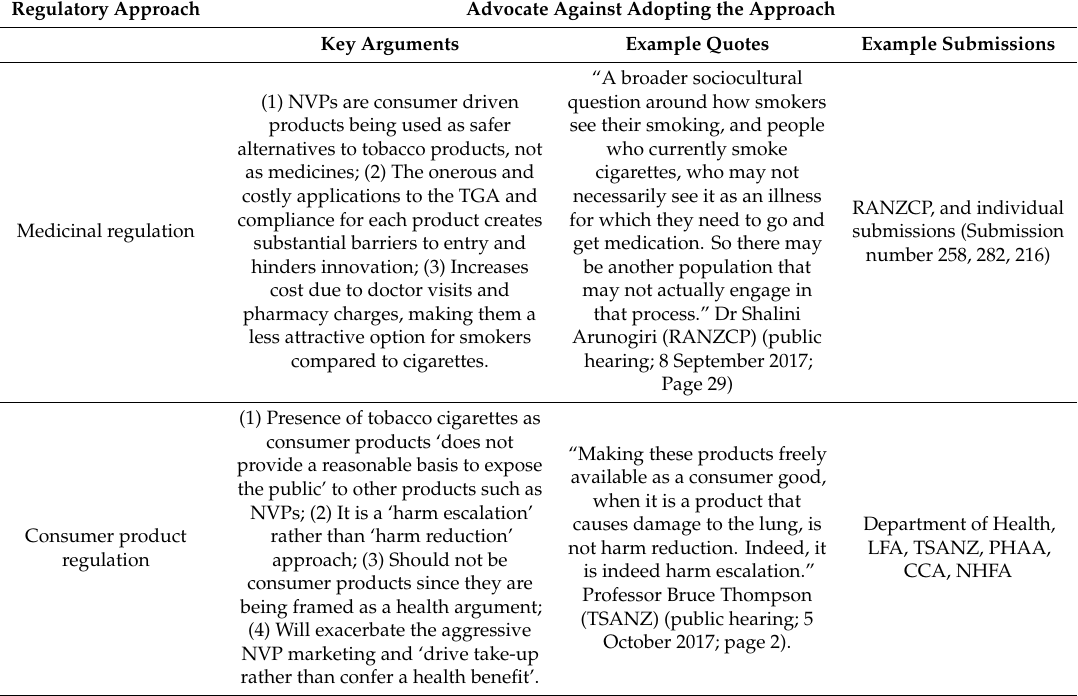
Arguments made against adopting various regulatory approaches for NVPs and example